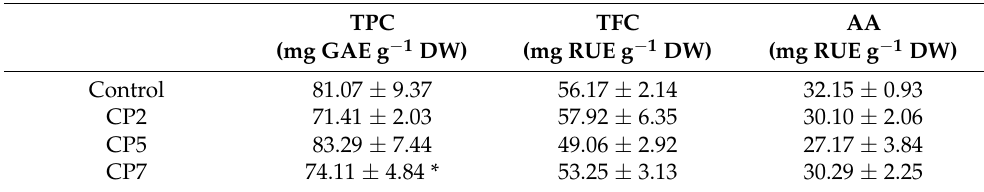
Table 4. The content of total phenolic compounds (TPC), total flavonoid compounds (TFC) and antioxidant activity (AA) in leaves of Stevia rebaudiana leaf grown for 12 weeks from control and CP-treated